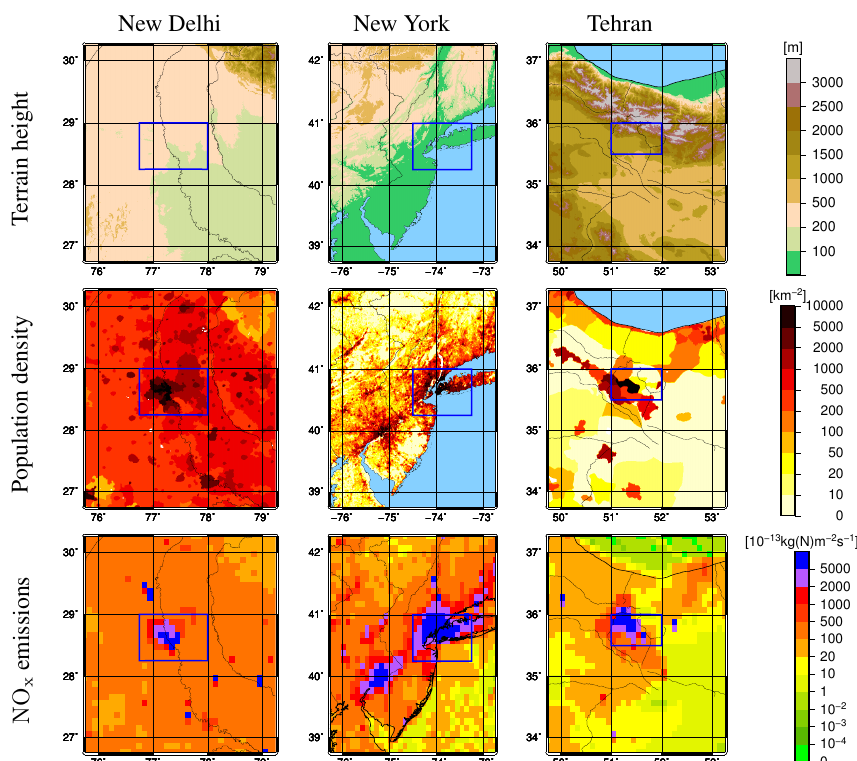
Fig. 19. Topography, population density, and NO x emissions for the three selected megacity regions New Delhi (India), New York (United States), and Tehran (Iran). Topographic data is from the GLOBE project (Hastings et al., 1998), population density data from the GRUMP dataset (CIESIN, IFPRI, the World Bank, and CIAT, 2011), and NO x emission values are from the EDGAR database (European Commission, JRC and PBL,